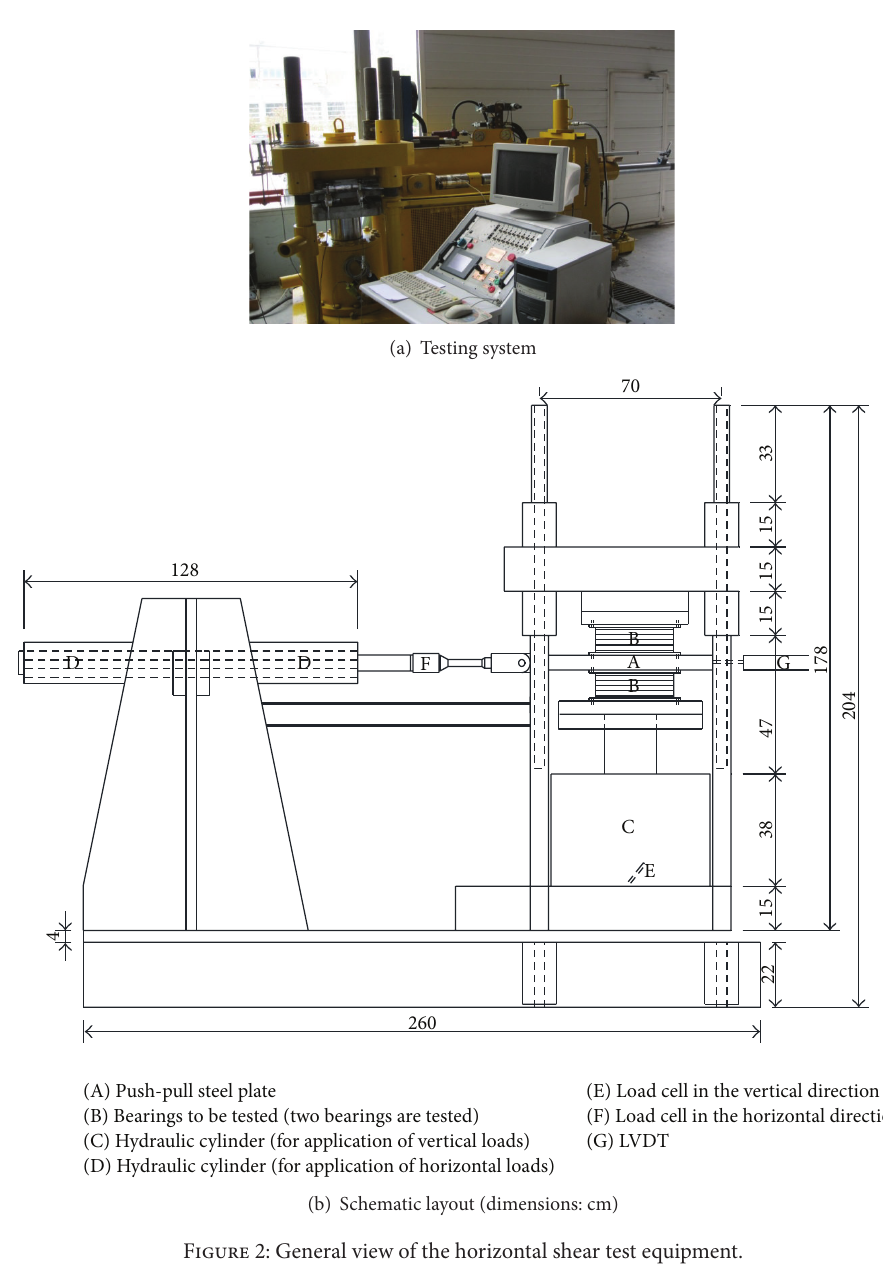
Figure 2: General view of the horizontal shear test equipment.